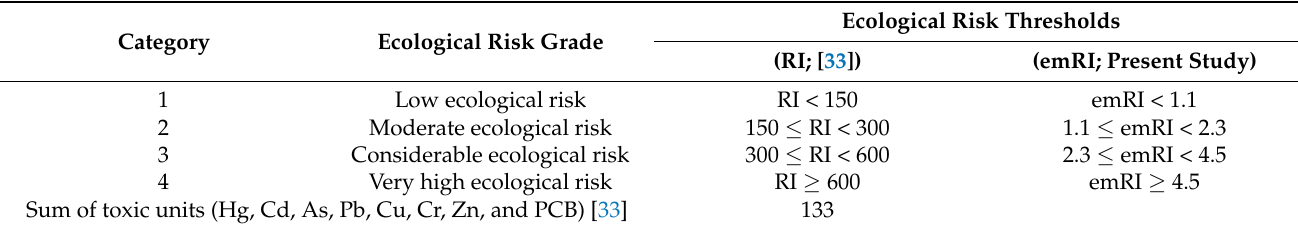
Table 3. Calculated values for the new classification of the expanded, modified potential ecological risk index (emRI) vs. the potential ecological risk index (RI).